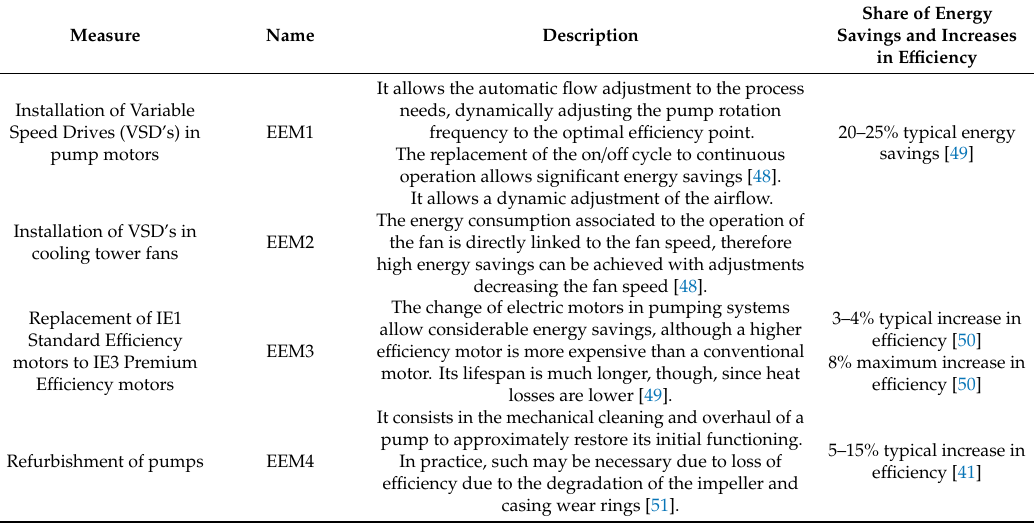
Table6. Descriptionofselectedimprovementmeasures. EEM:EnergyE ffi